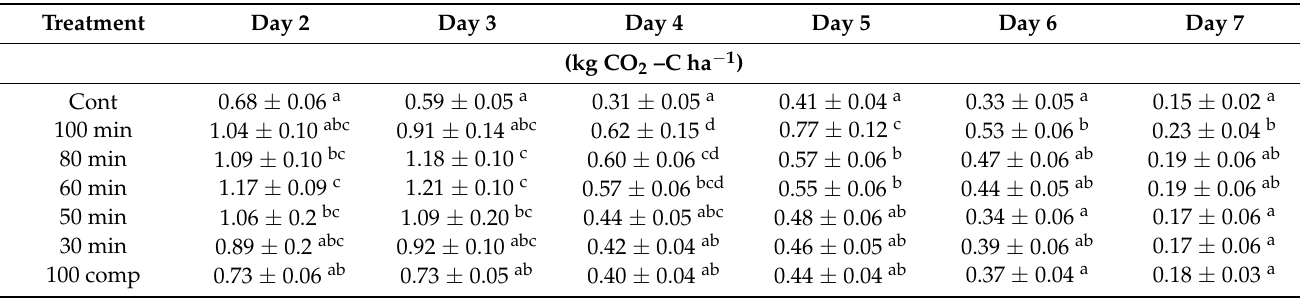
Table A3. Daily emission of carbon dioxide (CO 2 ) at 40% water-filled pore space in different fertilizer treatments (incubation experiment). Only the days with significant differences between the treatments are